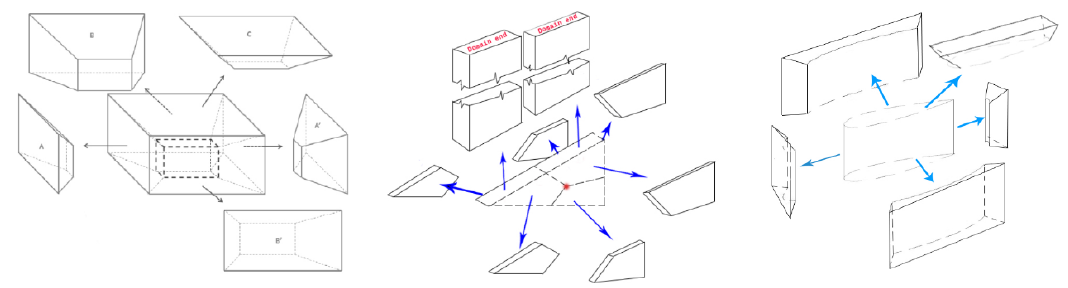
Figure 4. VG box based on meshing blocks for all studied geometries. VG box for Rectangular VG on the left from [14]. Triangular VG in the middle and Symmetrical VG NACA0012 on the